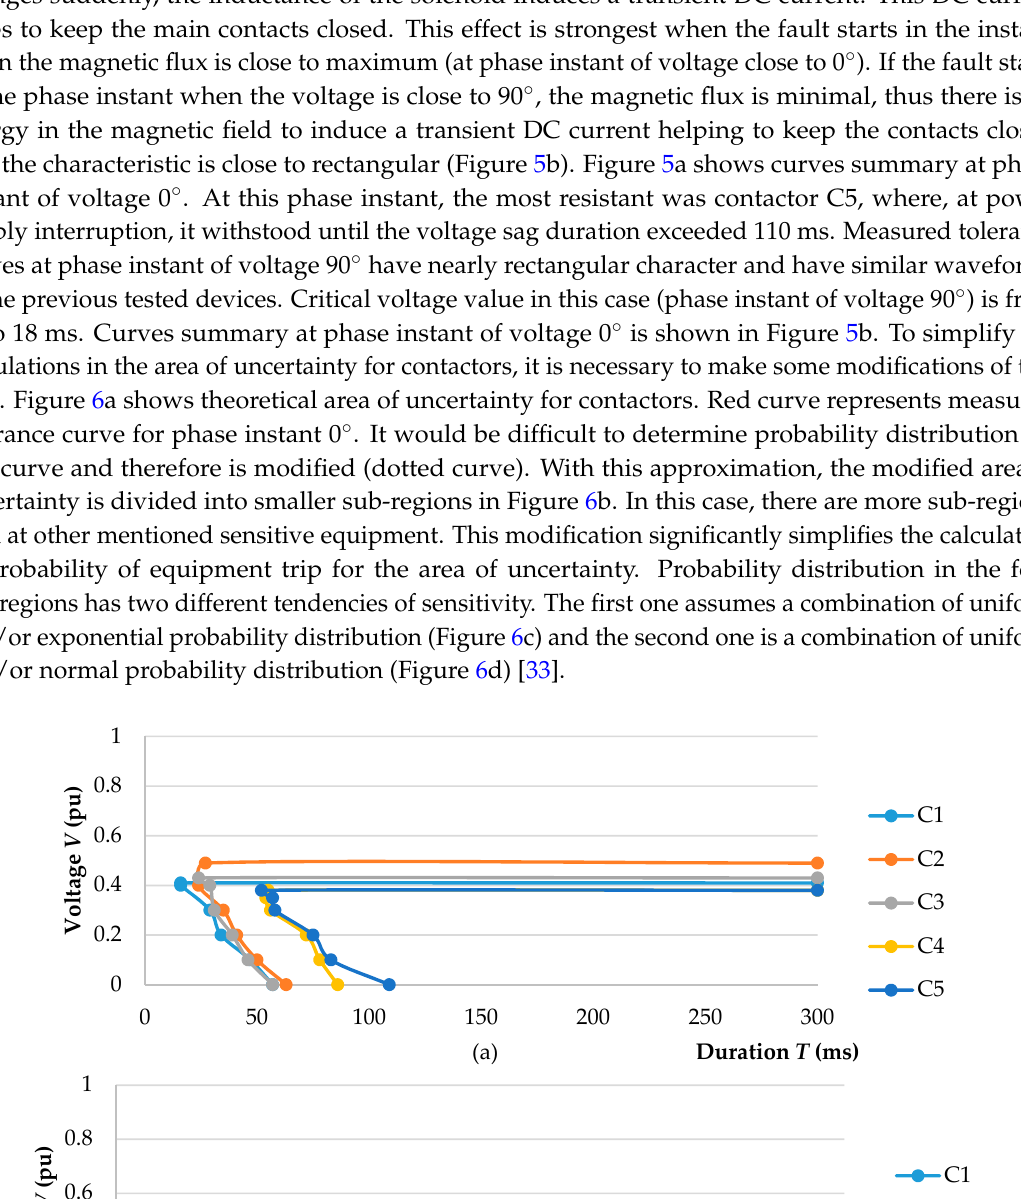
( d ) Figure 6. Area of uncertainty for contactors: ( a ) theoretical area of uncertainty for contactors; ( b ) area of uncertainty distribution; ( c ) considering the combination of uniform and/or exponential distribution in the individual sub-regions; and ( d ) considering the combination of uniform and/or normal distribution in the individual sub-regions. The area of uncertainty is formed in Figure 7 from measured curves of tested contactors (shaded area) and modified tolerance curve for phase instant of voltage 0° (red dotted line). According to the procedure described above, the final area of uncertainty for contactors, which consists of four sub- regions, is specified.